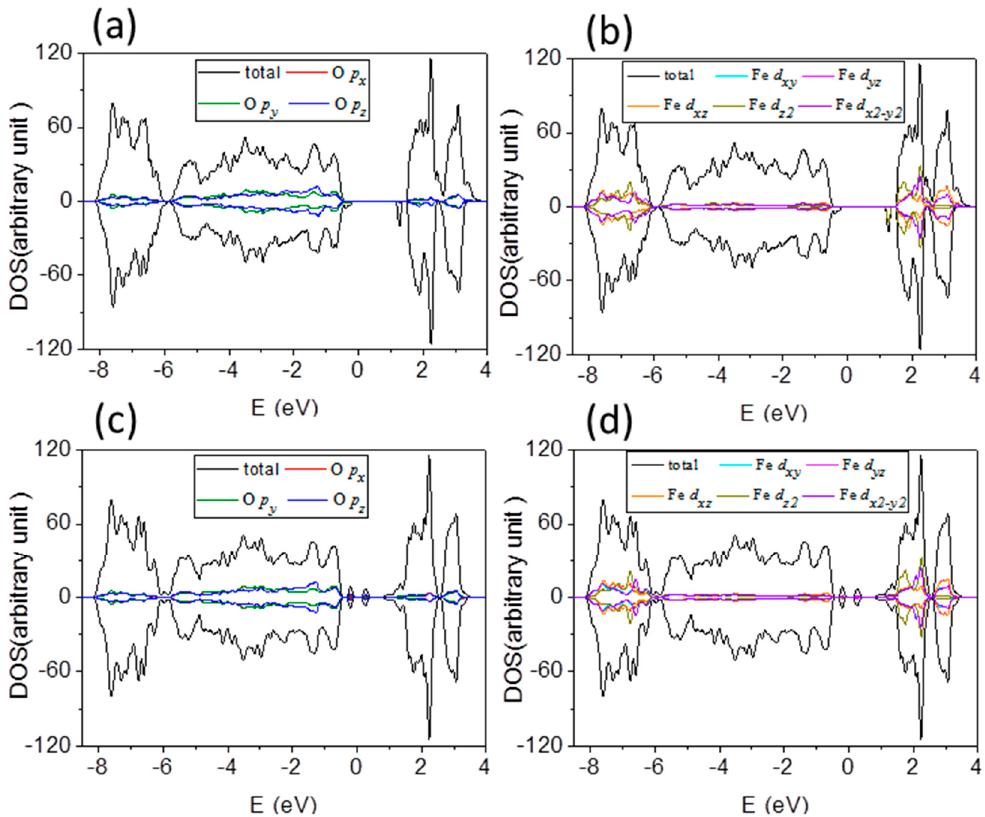
Figure 6. ( a , b ) Calculated density of states for O 2 p and Fe 3 d orbitals of Fe terminated α -Fe 2 O 3 1 × 1 × 3 film without strain, respectively, as labeled in different color; and ( c , d ) calculated density of states for O 2 p and Fe 3 d orbitals of O terminated α -Fe 2 O 3 1 × 1 × 3 film without strain, respectively. It is labeled in red, olive and blue for p x , p y , and p z orbitals of O atoms; and cyan, magenta, orange, dark yellow and violet for d xy , d yz , d xz , d z 2 and d x 2 orbitals of Fe atoms.